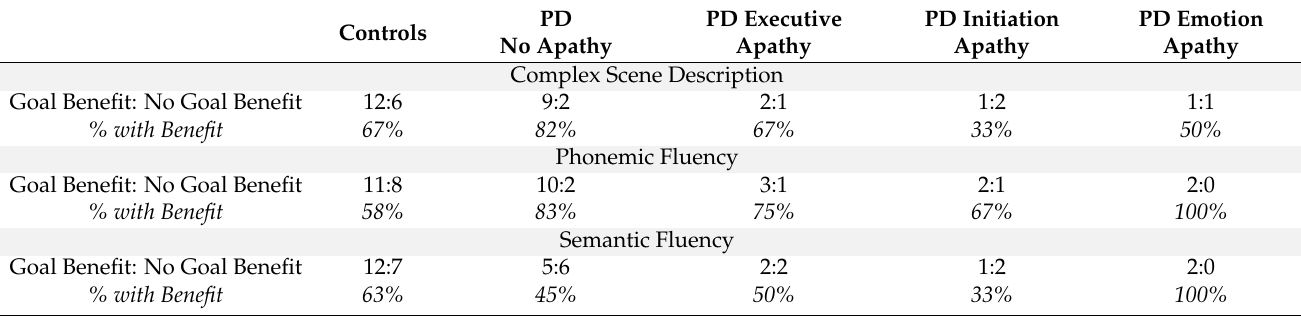
Table 7. Goal intervention benefit and apathy subtype: Number of PD participants that